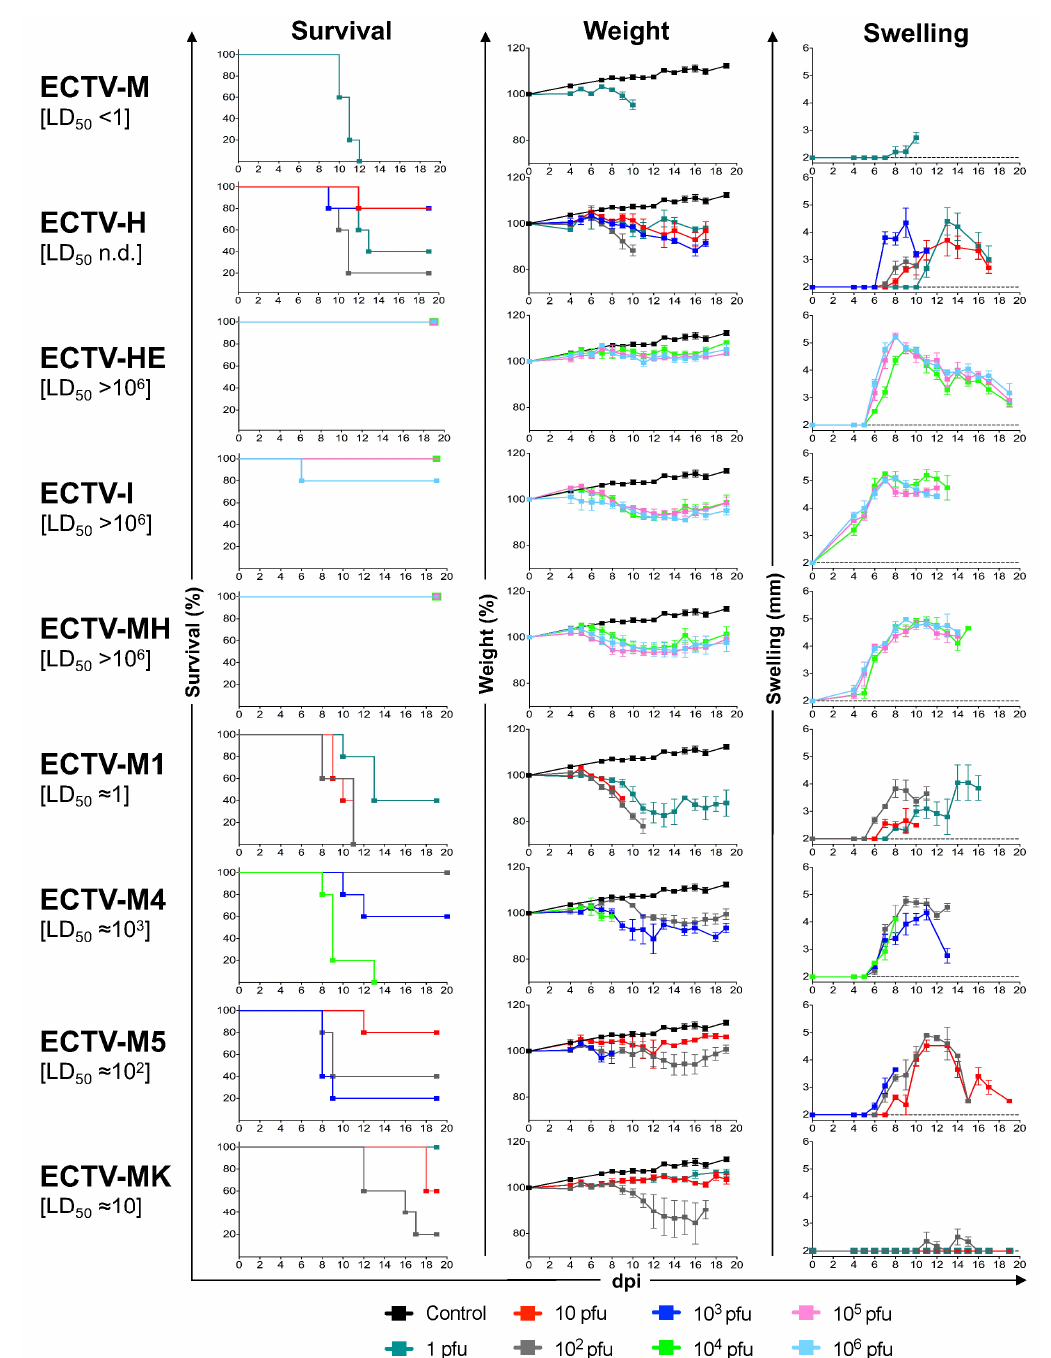
Figure 1. Virulence of ECTV isolates and strains in susceptible mice. Groups of five female BALB/cJ mice were infected s. c. in the footpad with the indicated ECTV and monitored during 19 d. The percentage of survival and weight, with respect to uninfected mice, and swelling of the inoculated foot are shown from left to right. Mice were infected with various doses: 1 pfu (dark green line in ECTV-M, ECTV-H, ECTV-M1, and ECTV-MK), 10 pfu (red line in ECTV-H, ECTV-M1, ECTV-M5, and ECTV-MK), 10 2 pfu (gray line in ECTV-H, ECTV-M1, ECTV-M4, ECTV-M5, and ECTV-MK), 10 3 pfu (dark blue line in ECTV-H, ECTV-M4, and ECTV-M5), 10 4 pfu (light green line in ECTV-HE, ECTV-I, ECTV-MH, and ECTV-M4), 10 5 pfu (pink line in ECTV-HE, ECTV-I, and ECTV-MH) or 10 6 pfu (light blue line in ECTV-HE, ECTV-I, and ECTV-MH). The black line represents control animals. Mean ± SD are represented. M, ECTV-M; H, ECTV-H; HE, ECTV-HE; I, ECTV-I; MH, ECTV-MH; M1, ECTV-M1; M4, ECTV-M4; M5, ECTV-M5; MK, ECTV-MK. The results shown with ECTV-MP1, ECTV-MP4, ECTV-MP5, ECTV-MK and ECTV-H are representative of two